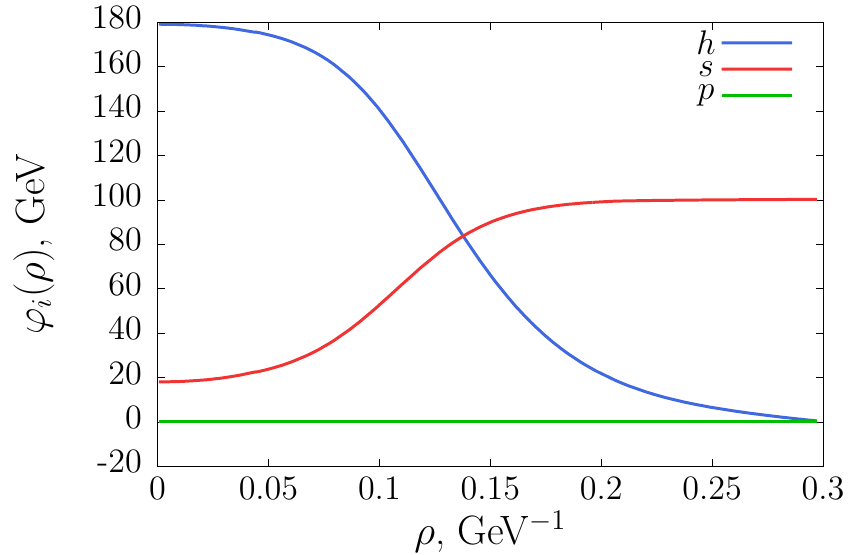
Figure 2 . Profile of the bounce solution for the benchmark model Q 5 at the nucleation temperature. Blue (top), red (middle) and green (bottom) curves correspond to h , s and p , respectively. The field ϕ i value in GeV is on the vertical axis, the distance to the origin in 3-dimensional space ρ in GeV − 1 is on the horizontal axis. The origin is in the bubble center. This graph was plotted using the package FindBounce